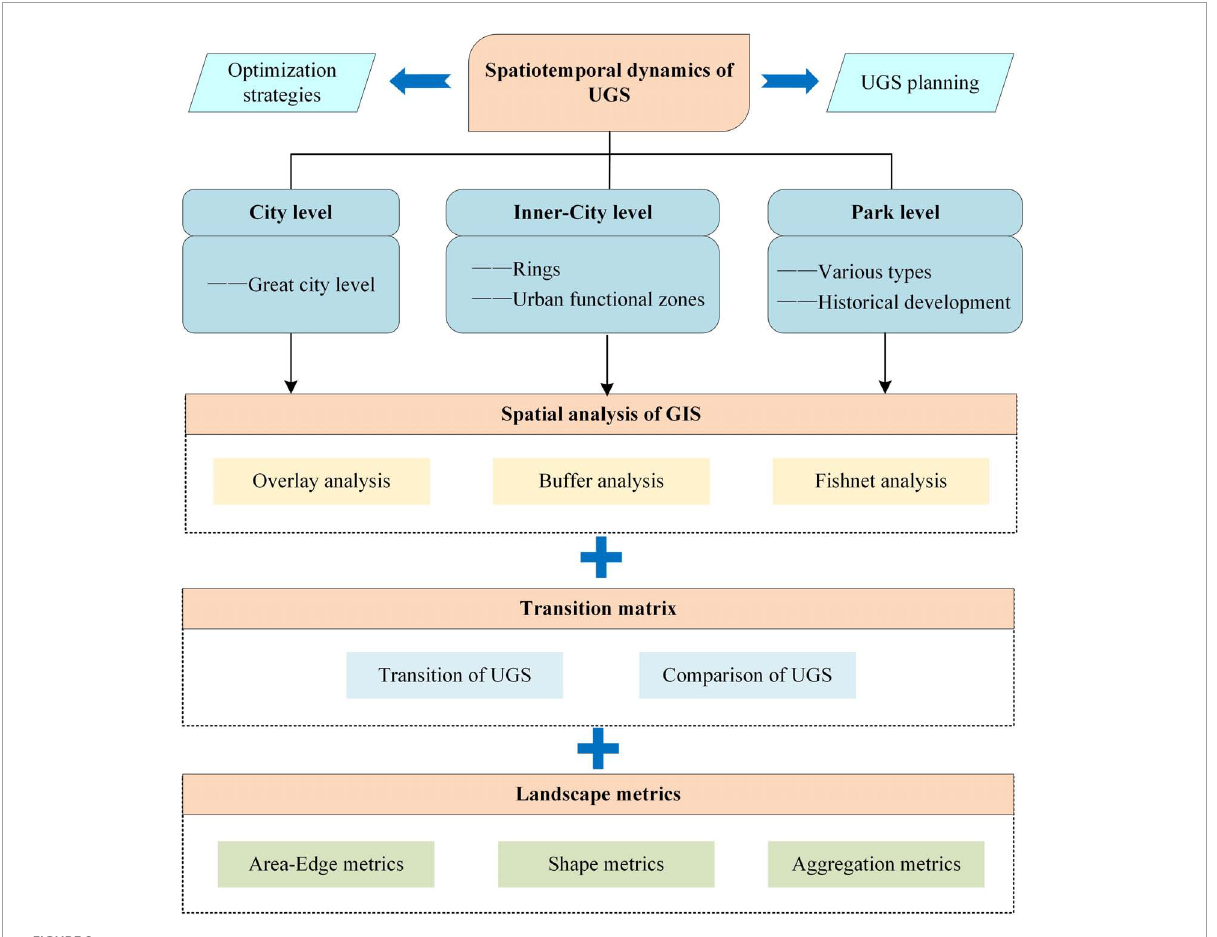
FIGURE2 Methodological flow